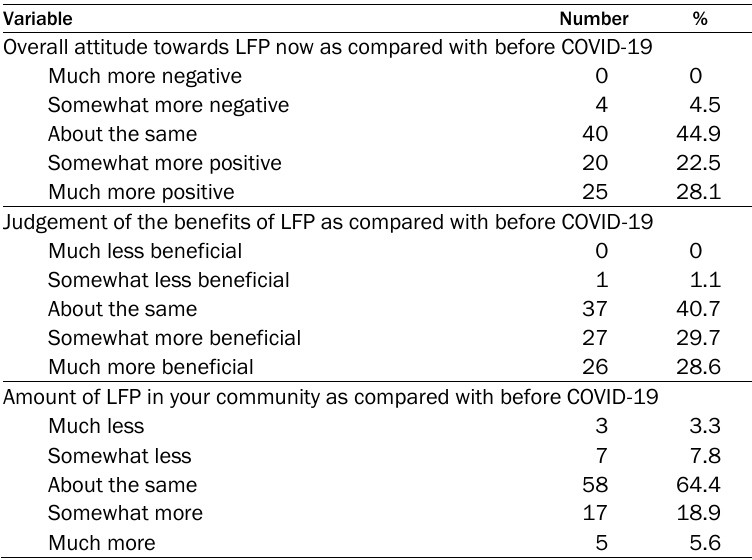
Table 9. Perceived Change in Attitudes, Benefits, and Activities Following COVID-19